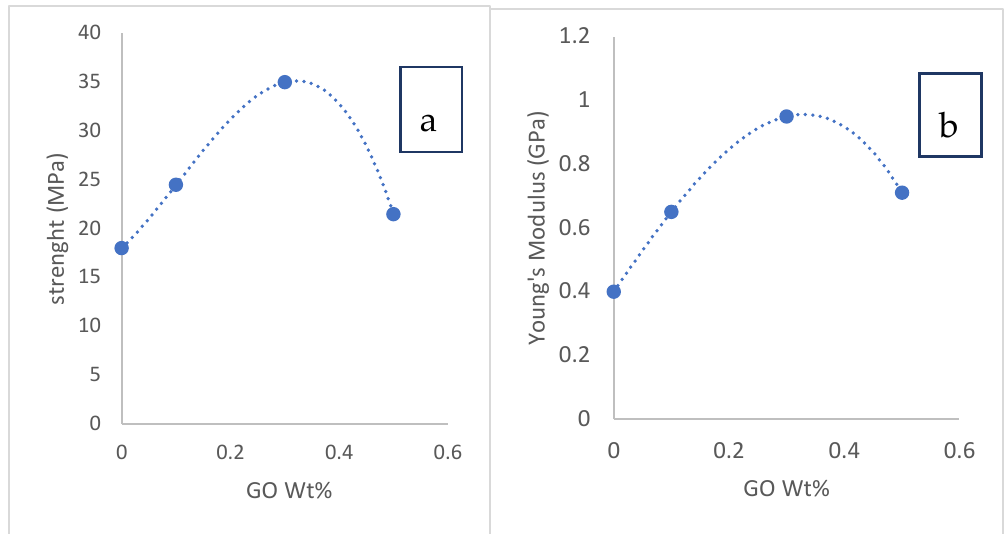
Figure 7. ( a ) Membrane strength versus GO concentration and ( b ) and Young’s modulus for the CTA/GO membranes with increasing GO loading.